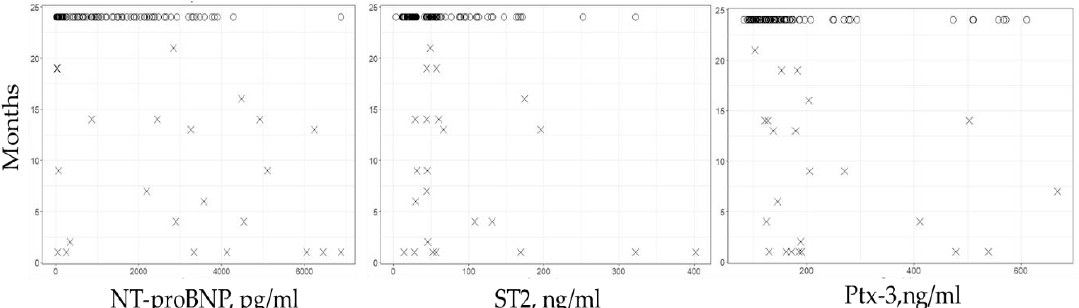
Figure 3. Scatter plots of the investigated biomarkers with associated survival rates (indicated in month) during a two-year FU after STEMI. Cases of CV mortality are indicated by a cross while cases of non-CV mortality are indicated by a circle.